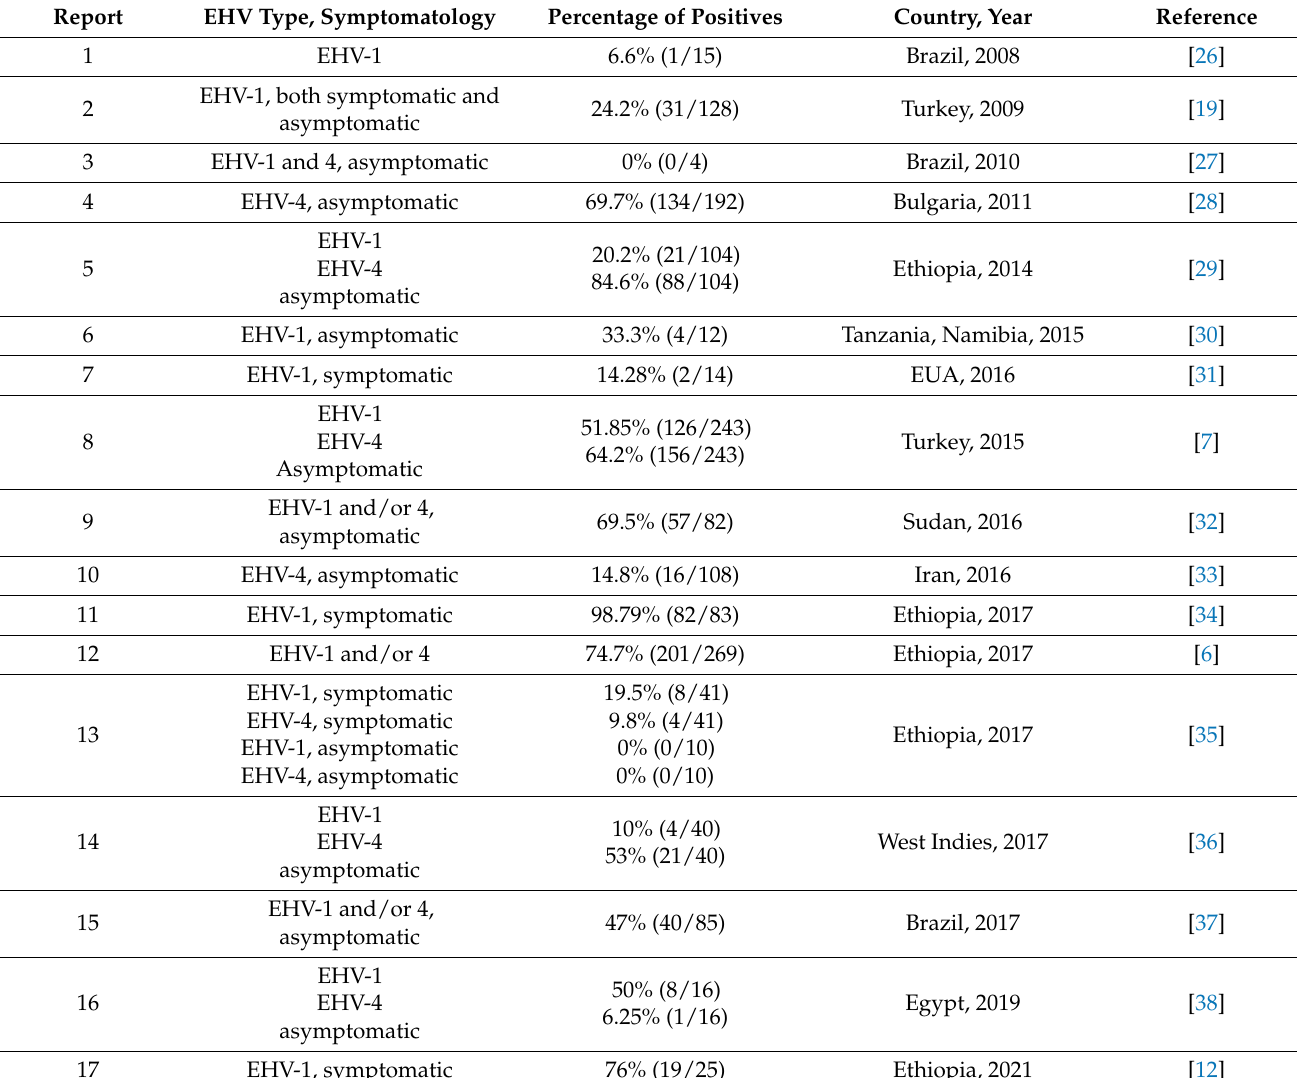
Table 2. Overview of reports documenting seroprevalence of EHV-1 and EHV-4 in donkeys, 2008 to